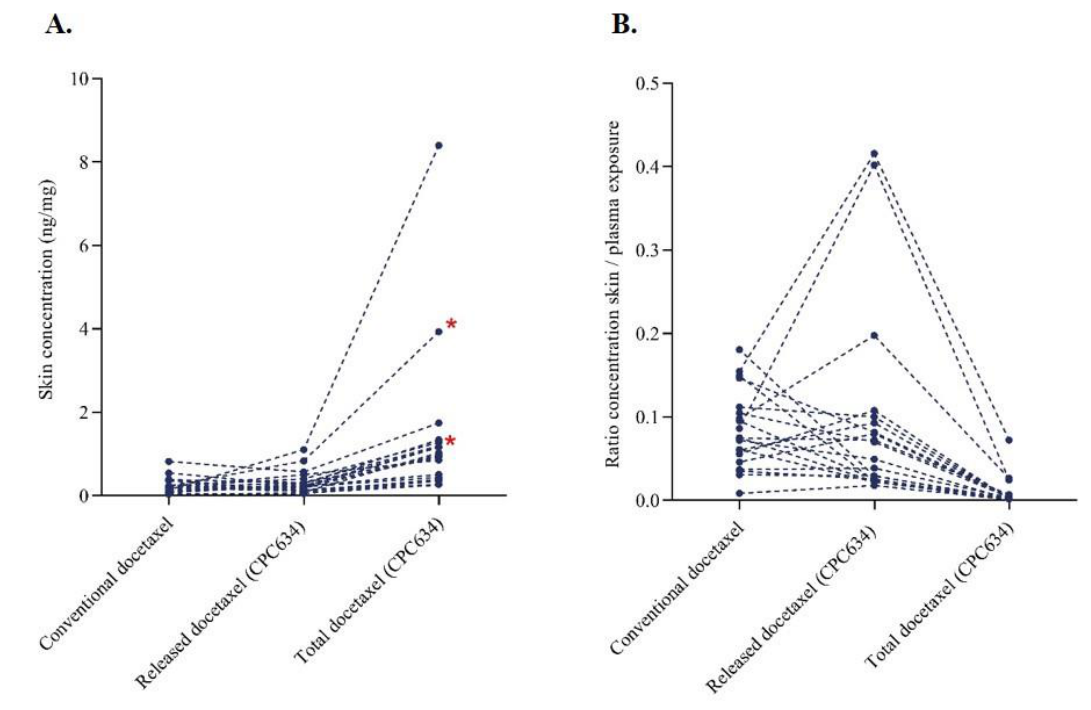
Figure 1. Docetaxel pharmacokinetics in the skin. ( A ) Docetaxel concentration in the skin after conventional docetaxel and CPC634 (released and total) administration ( n = 20). ( B ) Docetaxel concentration ratio in the skin relative to plasma docetaxel concentration. * In these patients, skin biopsies were taken on day 15 of both cycles ( n = 2). Table 1. Intratumoural docetaxel difference (for both CPC634 and conventional docetaxel) relative to the skin.